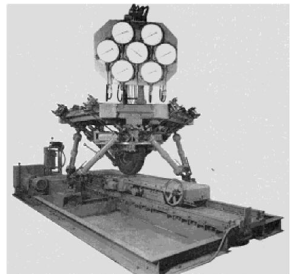
Figure 7 Flight simulator using Stewart mechanism